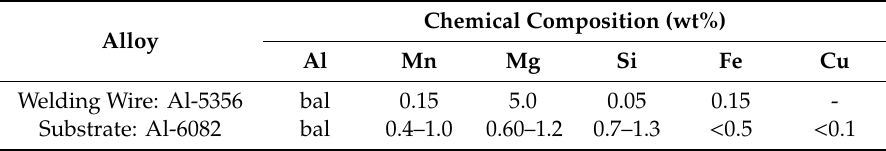
Table 1. Nominal composition of welding wire and substrate material.